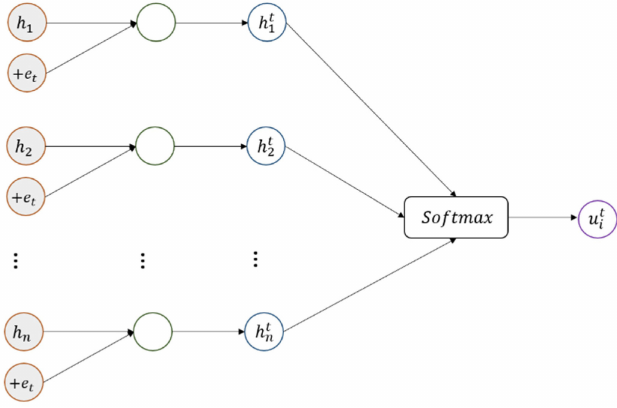
Figure 3. Attention score of the specific upper-level